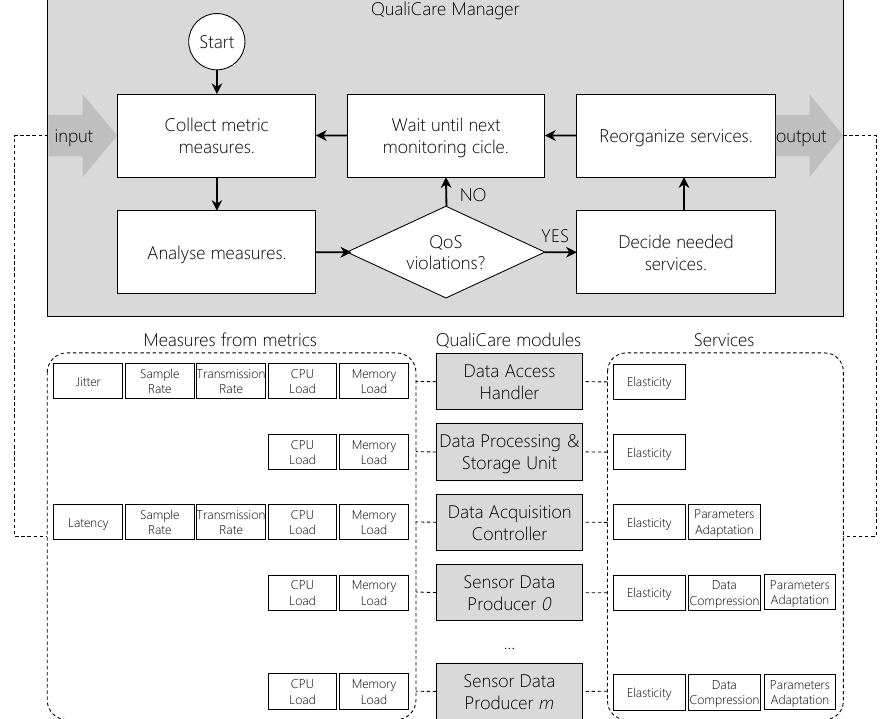
Figure 8. QualiCare Manager main monitoring cycle showing the service distribution and the metrics it evaluaves. The idea is to monitor module metrics and organize services according to the